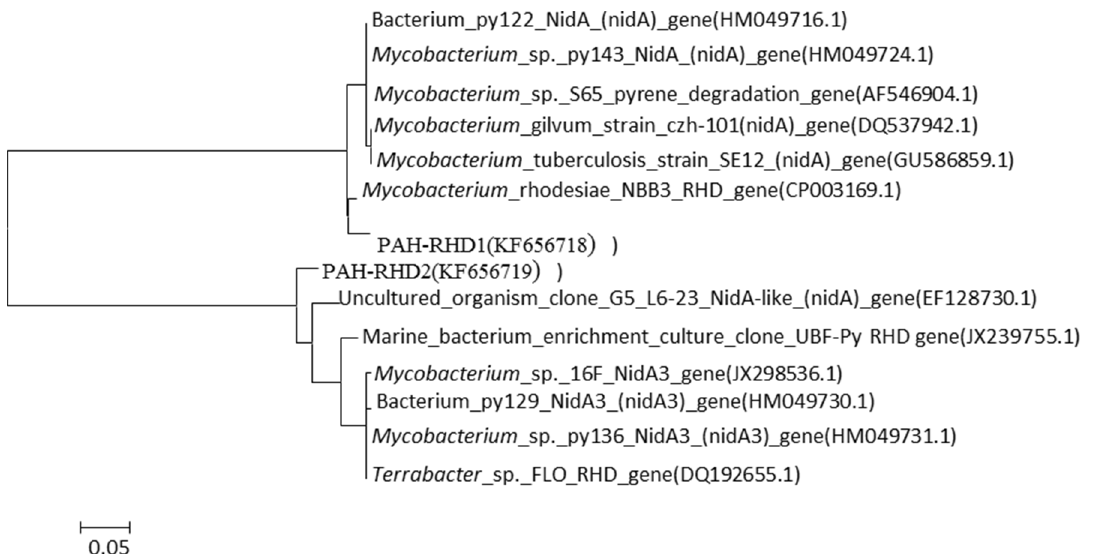
Fig 2. Phylogenetic tree of PAH-RHD α gene. Phylogenetic relationship of PAH-RHD α gene cloned from soil treated by 1 mg/kg phenanthrene. PAH-RHD1 and PAH-RHD2 showed 97% and 92% similarity with genes from Mycobacterium_rhodesiaee and uncultured organism, respectively.